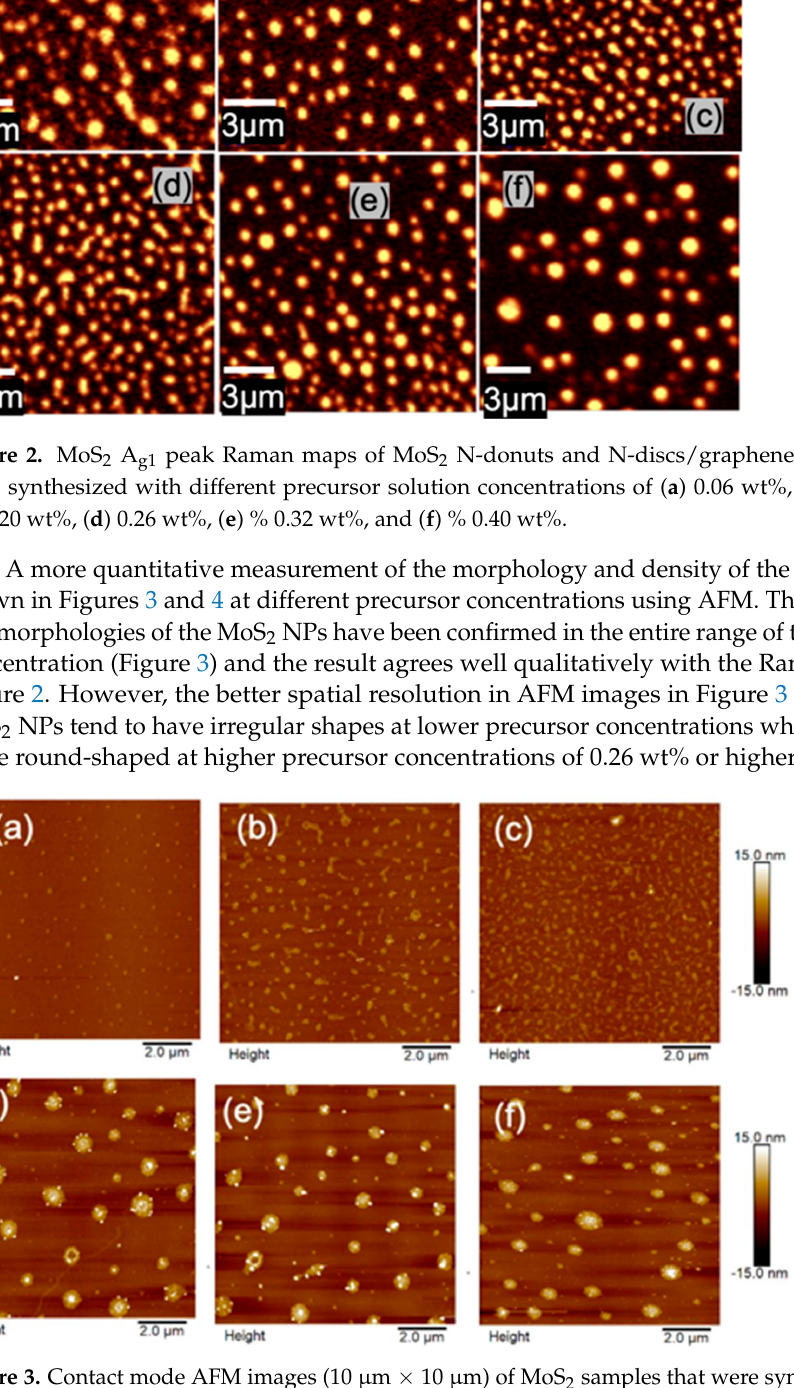
Figure 3. Contact mode AFM images (10 µm × 10 µm) of MoS 2 samples that were synthesized with different precursor solution concentration. ( a ) 0.06 wt%, ( b ) 0.10 wt %, ( c ) 0.20 wt%, ( d ) 0.26 wt%, ( e ) 0.32 wt%, and ( f ) 0.40 wt%. AFM images of 5 µm × 5 µm at selected concentrations of 0.06 wt%, 0.26 wt%, and